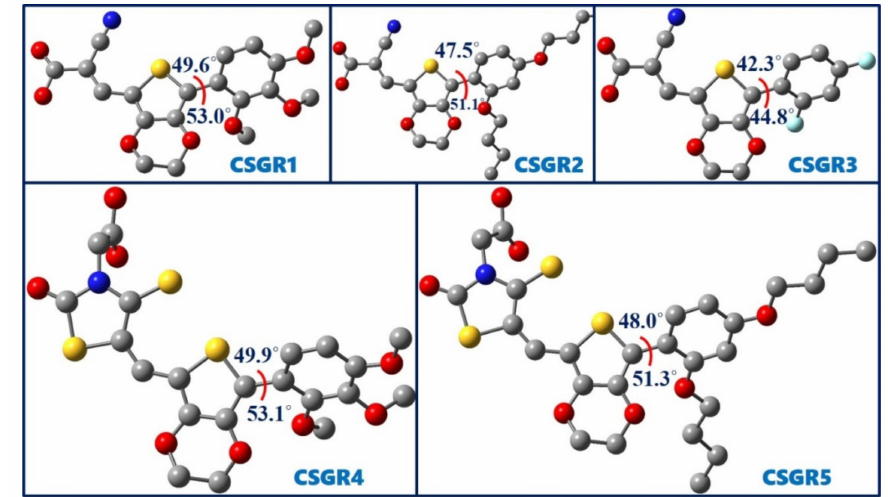
Figure 8. Optimized ground state geometries of the dyes CSGR1 to CSGR5 obtained at B3LYP / 6-31G(d) level of